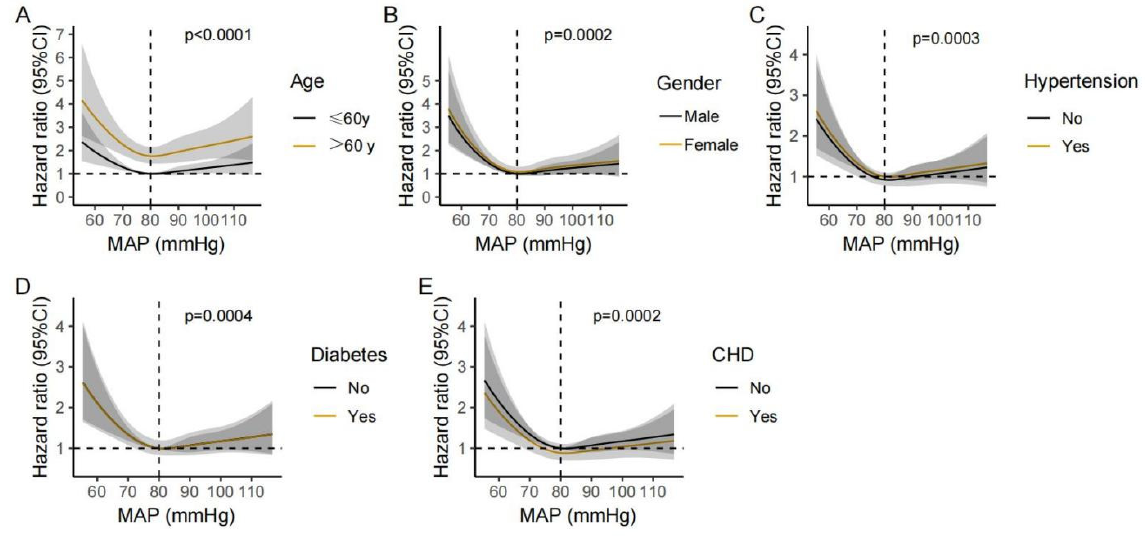
Figure 6. Non-linear association between MAP and the 28-day mortality of stroke patients in different subgroups. Hazard ratio and 95% CI were visualized using ribbons for following subgroups: age > 60 or ≤ 60 ( A ), male or female ( B ), with or without hypertension ( C ), with or without diabetes ( D ), and with or without CHD ( E ).